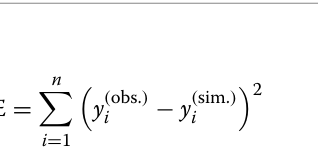
Fig. 3 Observed bathymetry data after the Anak Krakatau eruption: a the surveyed area and b a comparison between the previous and current bathymetry along the red dotted line in the top